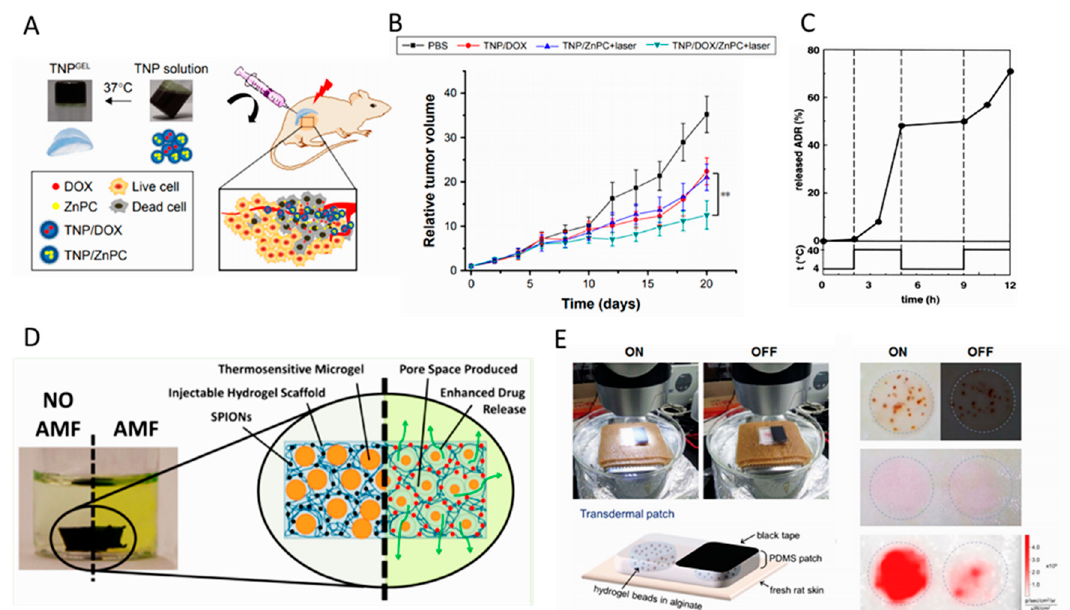
Figure 4. ( A ) Illustration of photo / chemo combination therapy via in situ formed thermal-sensitive polymer hydrogel (TNP) in a xenograft tumor model. Doxorubicin and zinc phthalocyanine loaded TNP polymer solution is transformed to gel state after injecting, to be used for localized photodynamic therapy. Adapted with permission from Huang et al. [77]; ( B ) relative tumor volume of the mice model in di ff erent treatment conditions showing the significance of concurrent localized chemo / PDT therapy. Adapted with permission from Huang et al. [77]. ( C ) Thermal fluctuations and corresponding on / o ff switch release of drug from thermo-responsive PIPAAm-PBMA micelles through the low critical solution temperature (LCST). Adapted with permission from Chung et al. [82]. ( D ) Hydrazide-functionalized poly N-isopropylacrylamide (PNIPAAm) microgels in a magnetic nanoparticle-containing matrix using for pulsatile on / o ff release of drugs in response to an external magnetic field. Adapted with permission from Campbell et al. [83]. ( E ) Ex vivo setup of the light-triggered release of the skin patch with drug reservoirs containing rhodamine-loaded hydrogel beads. It is shown that by the exposure of the visible light (LED lamp (30 mW · cm − 2 ) for 6 h), rhodamine is released from the Polydimethylsiloxane (PDMS)skin patch, which is significantly higher than that of “o ff “condition. Adapted with permission from Kim et al. [89].